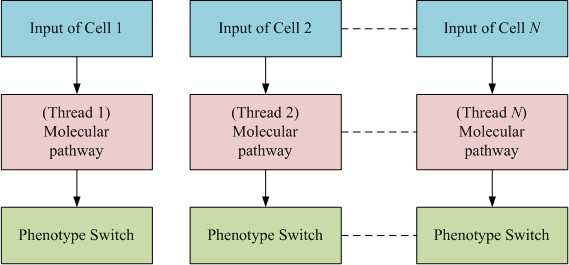
Parallel ODE Solver.